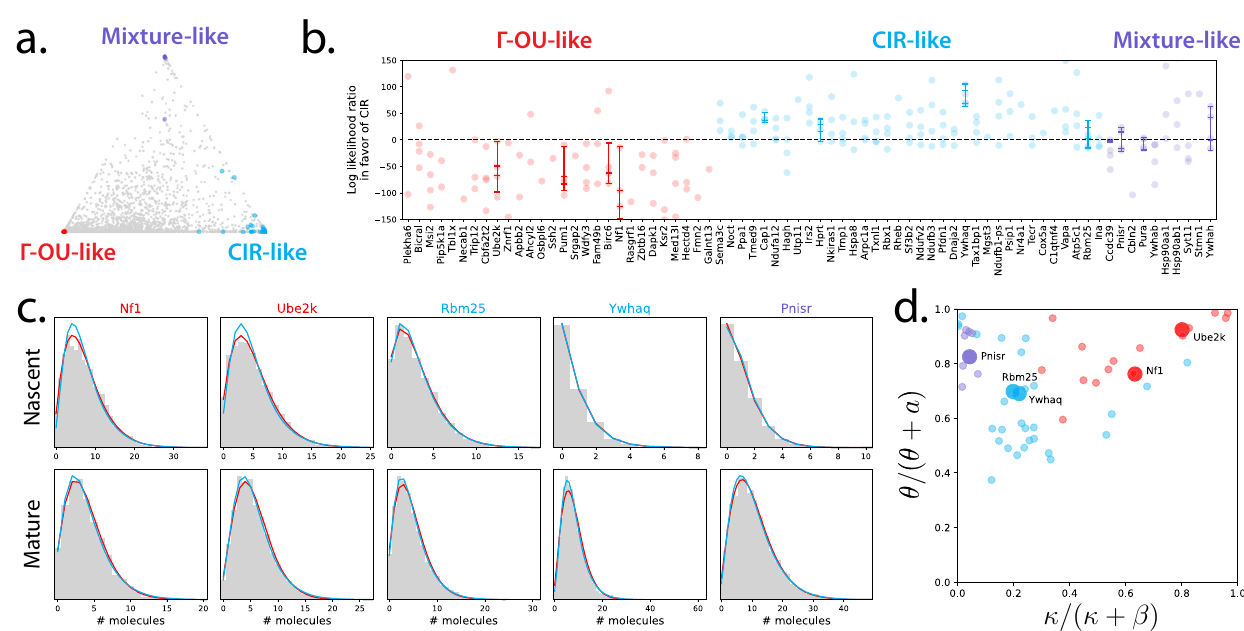
Fig. 4 | Genes from comparable single-cell RNA sequencing datasets can be consistently assigned to a particular biophysical model of transcription. a By fi tting models in the limiting regimes and calculating model Akaike weights, visualized on a ternary diagram, we can obtain coarse gene model assignments (colors: regimes predicted by the partial fi t; red: Γ -OU-like genes; blue: CIR-like genes;violet:mixture-likegenes;gray:genesnotconsistentlyassignedtoalimiting regime). b Likelihood ratios for selected genes are consistent across biological replicates, and favor categories consistent with predictions (colors: regimes pre- dicted by the partial fi t; points: likelihood ratios; horizontal line markers: Bayes